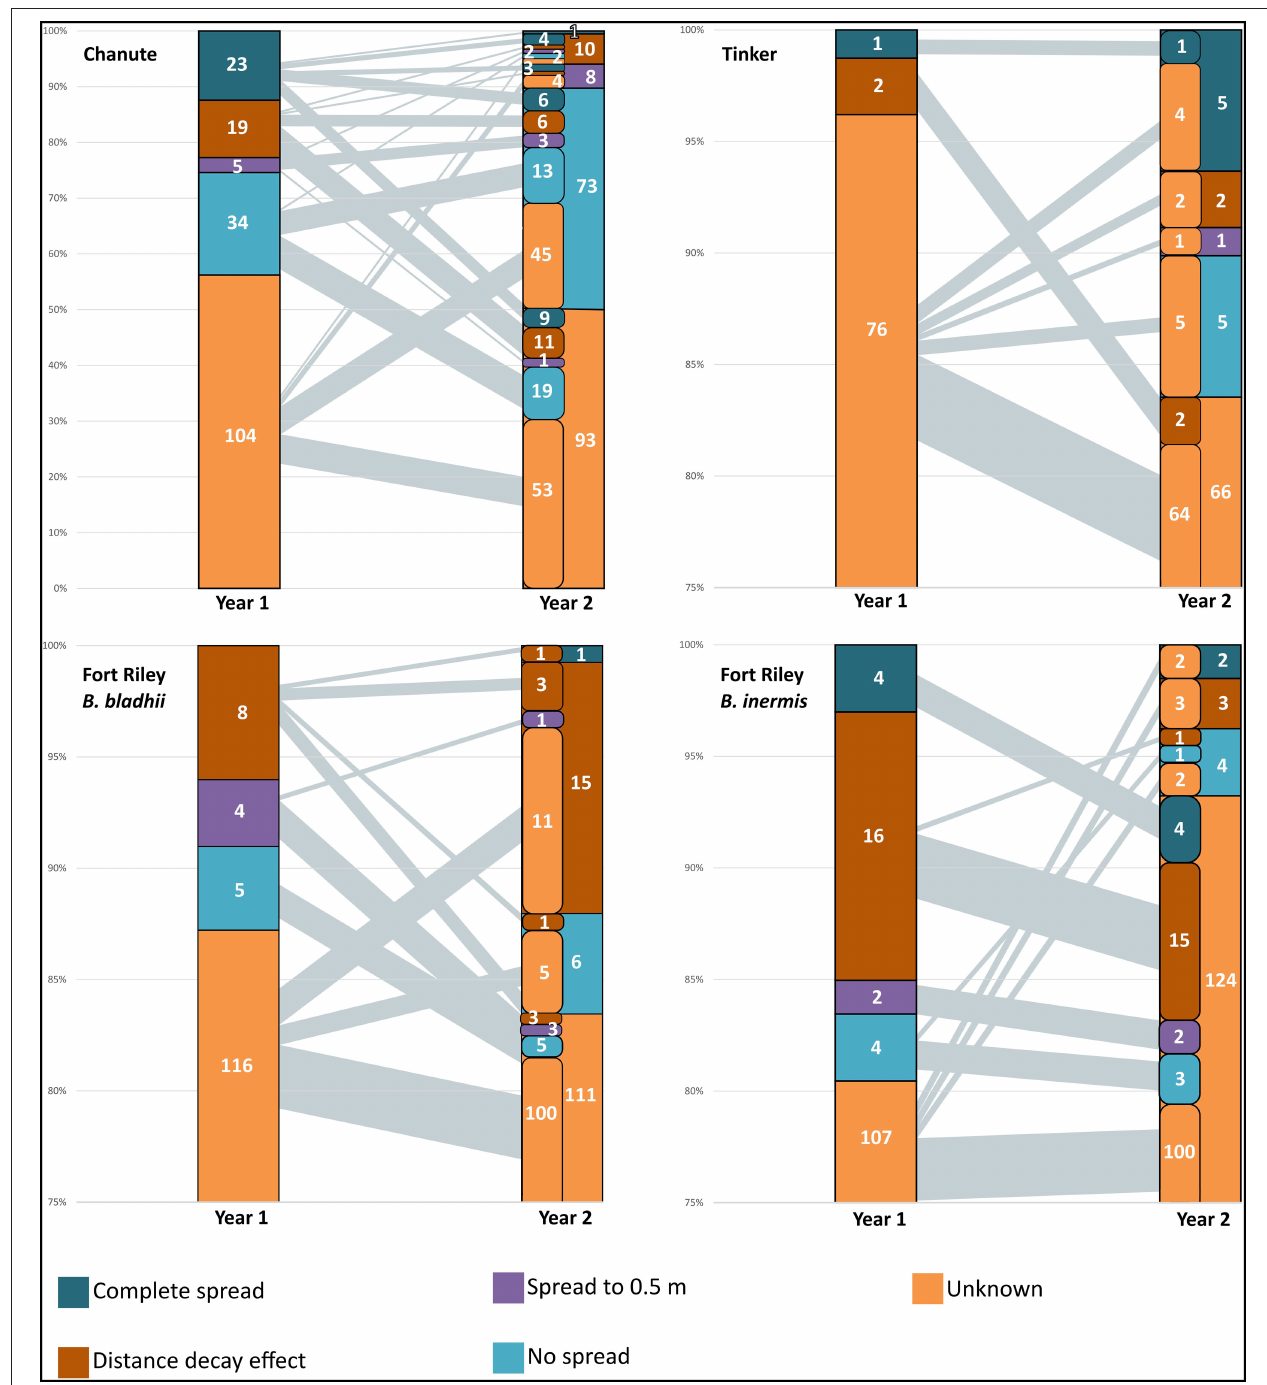
FIGURE 2 | Spread of AMF OTUs from nurse plant row by sites in years 1 and 2. The number of OTUs in each spread category is presented. The left-side column in year 2 represents the contribution of OTUs from year 1 categories in each year 2 category. Black lines from year 1 to year 2 represent the amount of OTUs from categories in the first year to the second—the thicker the line, the greater the amount of OTUs from year 1 category in the year 2 category. The largest category in all sites was unknown, and there was evidence of the complete spread of some AMF in all sites by the second year.